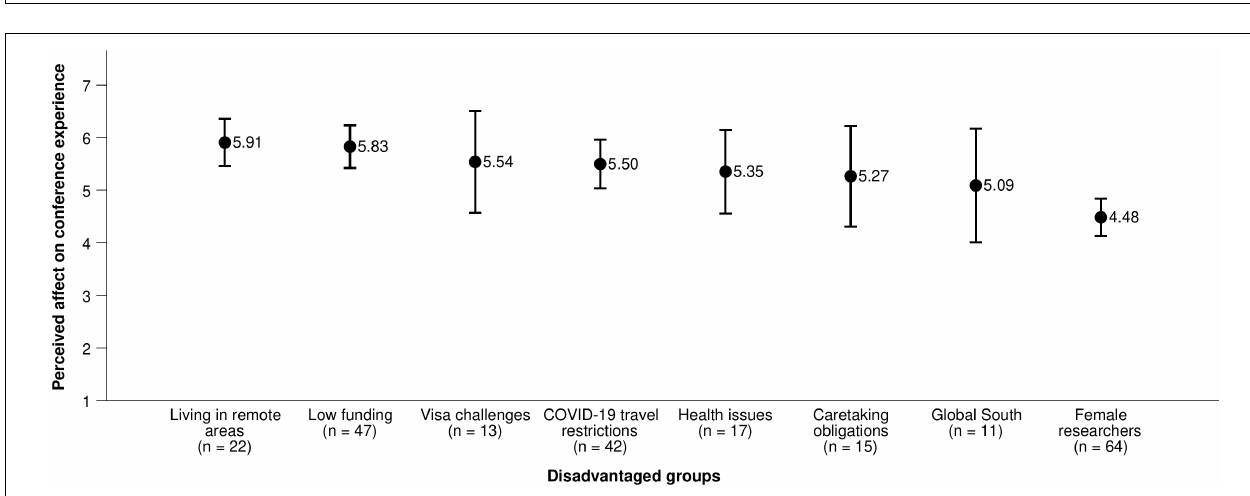
FIGURE 1 | How a virtual conference format would affect the conference experience of participants’ groups. Variables were measured on a scale from 1 (it would make their experience much worse) and 7 (it would make their experience much better). Error bars represent 95% confidence intervals.